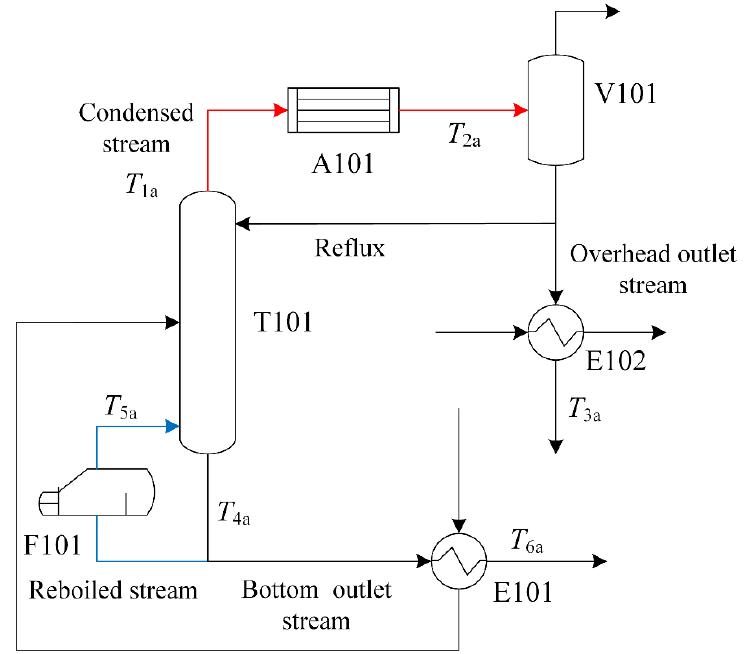
Figure 1. Distillation column and related streams.